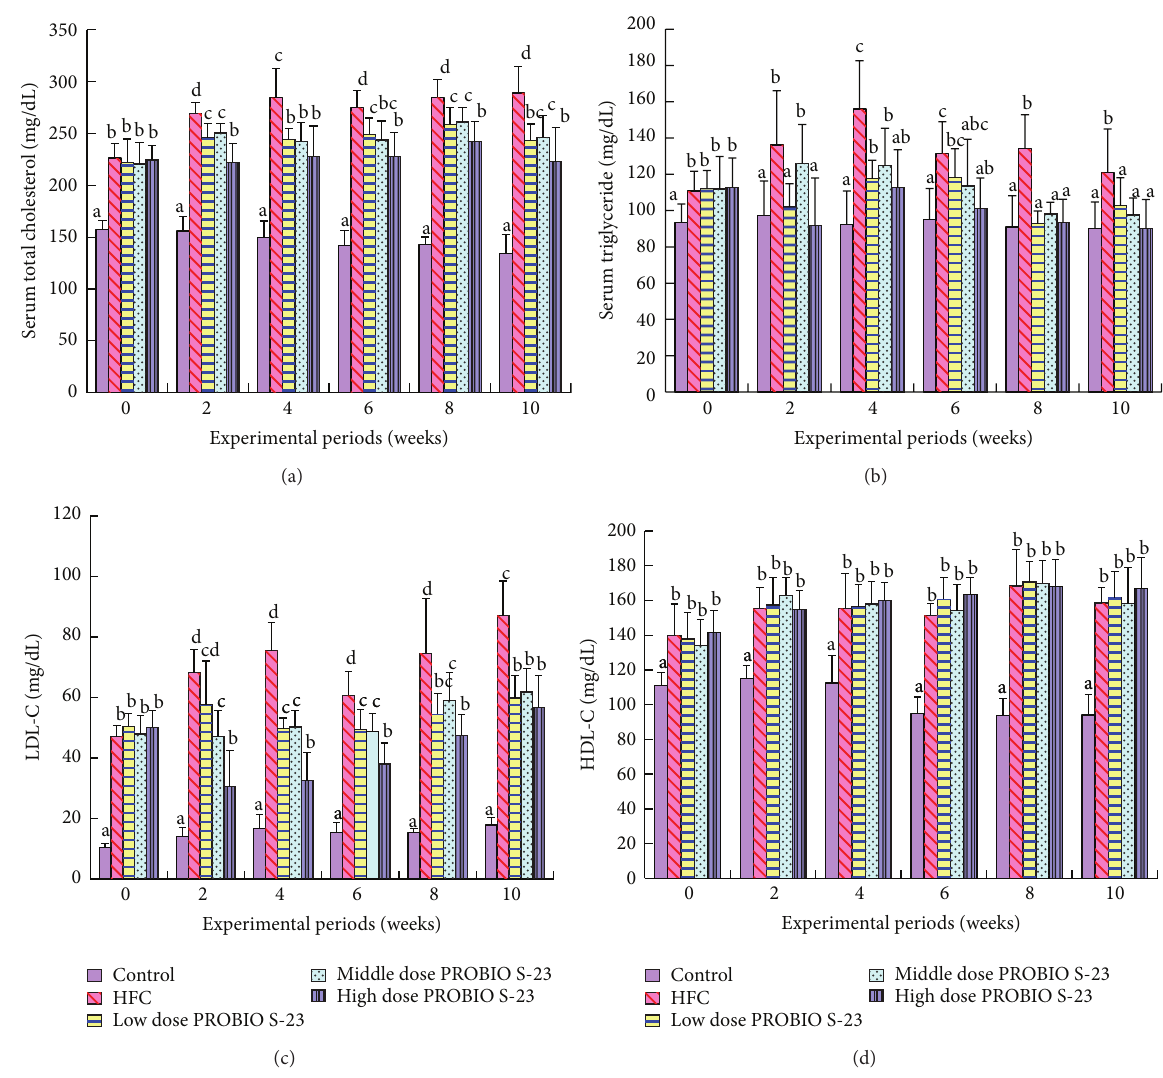
Figure 6: Effects of different concentrations of PROBIO S-23 Complex product on serum (a) total cholesterol, (b) triglyceride, (c) LDL-C, and (d) HDL-C of hamsters fed with high-fat plus high-cholesterol diet during 10 weeks of experimental